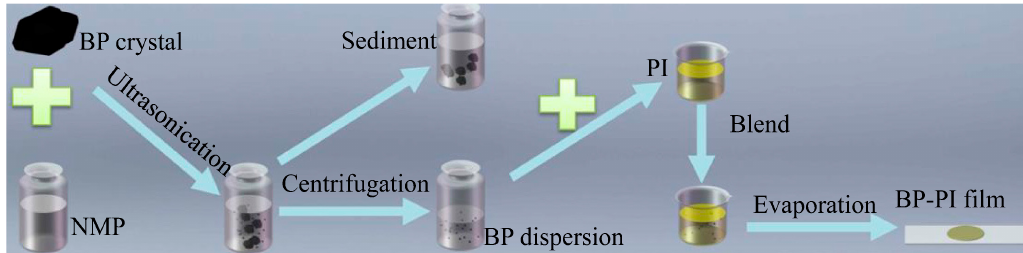
Figure 1. Schematic diagram for preparing BP–PI films. NMP: N -methylpyrrolidone; black-phosphorus: BP; polyimide: PI.